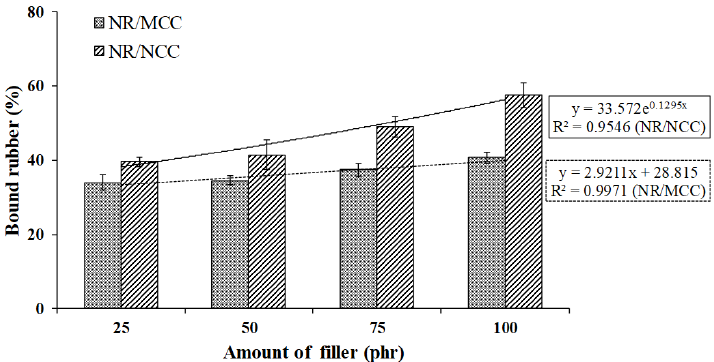
Figure 4. Bound rubber for natural rubber (NR) with various sizes (MCC vs. NCC) and amounts of filler (25, 50, 75, and 100 phr).